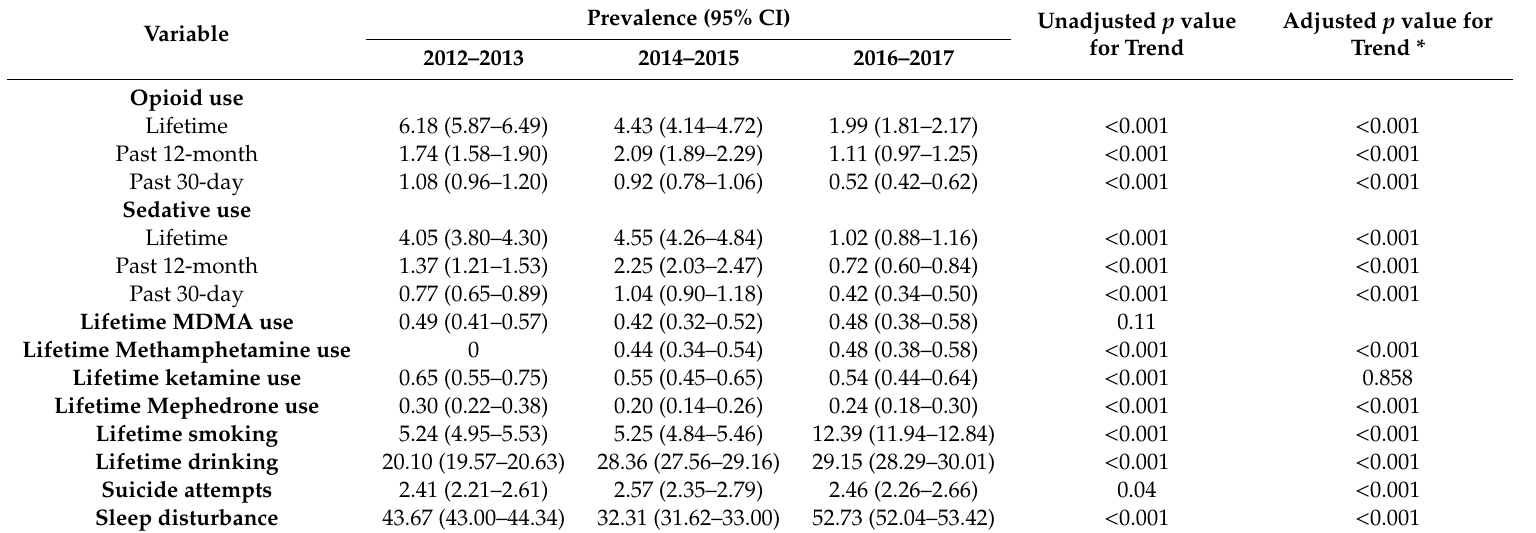
Table 1. Prevalence estimates of health-risk behaviors among Chinese